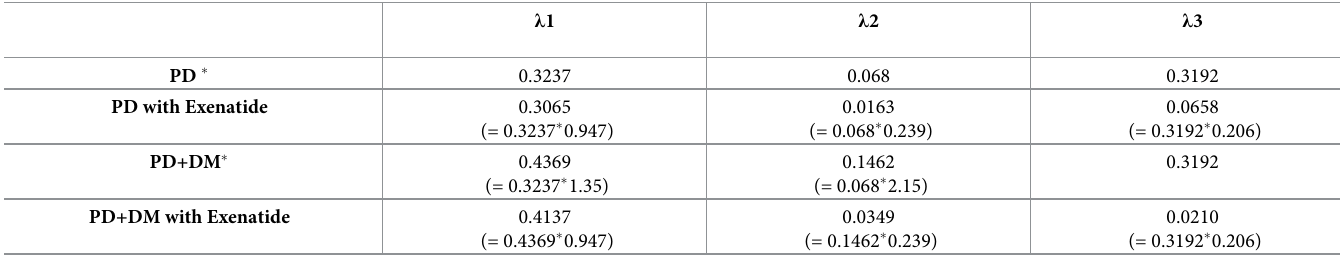
Table 1. H-Y stage transition rate in different